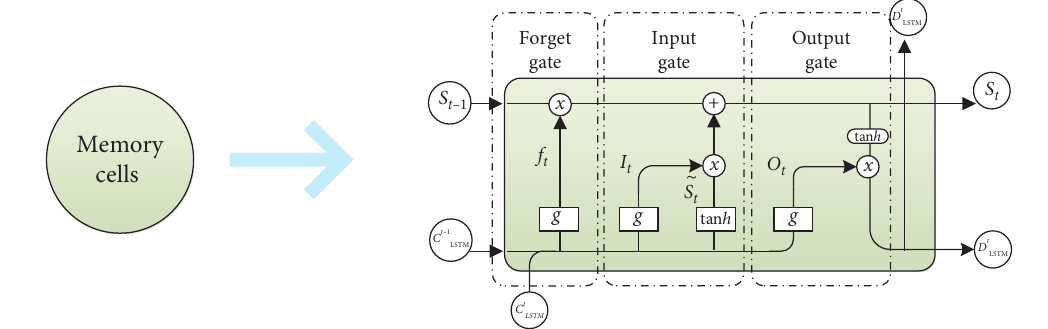
Figure 4: Structural model diagram of the LSTM memory